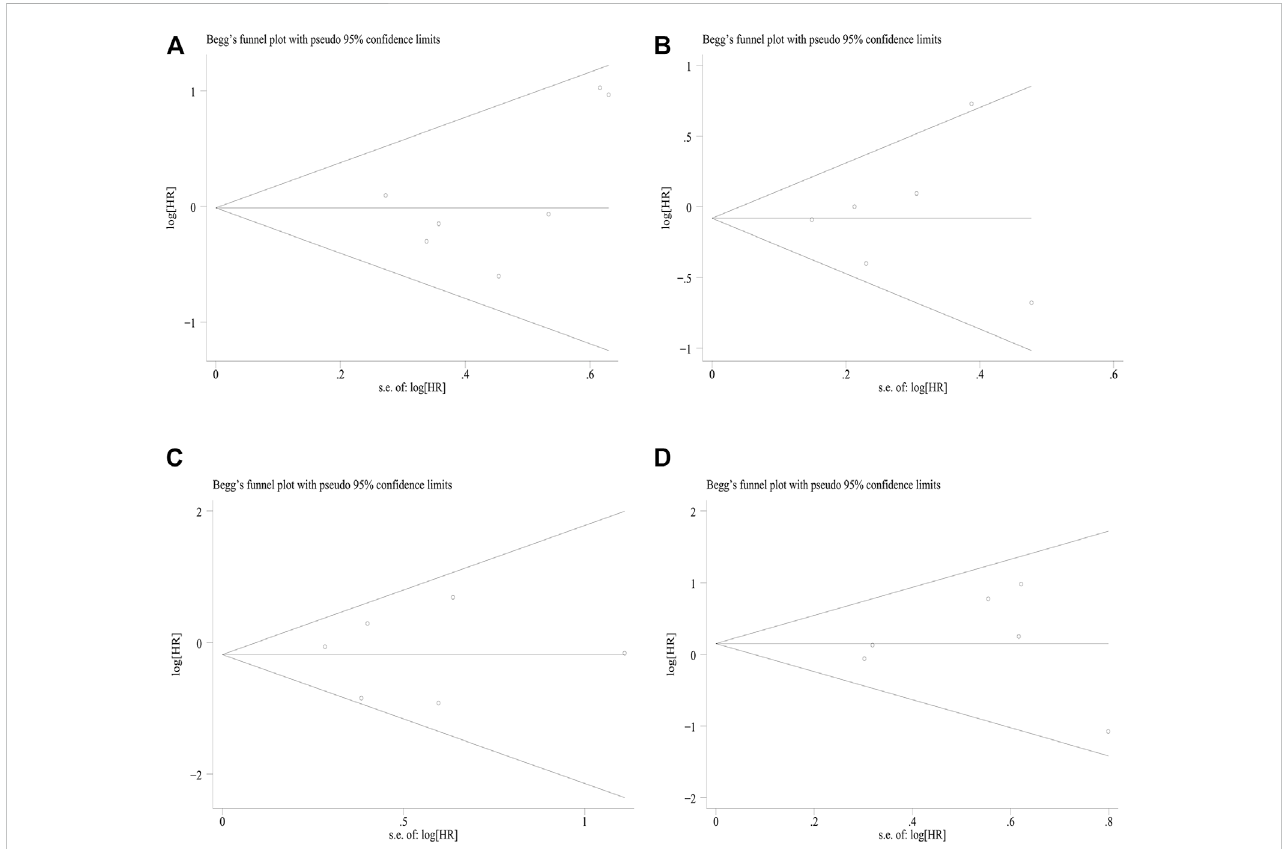
FIGURE 6 Publication bias assessed by funnel plot of (A) OS; (B) PFS; (C) DMFS; (D) LRFS. OS, overall survival; PFS, progression-free survival; DMFS, distant metastasis-free survival; LRFS, locoregional recurrence-free survival.